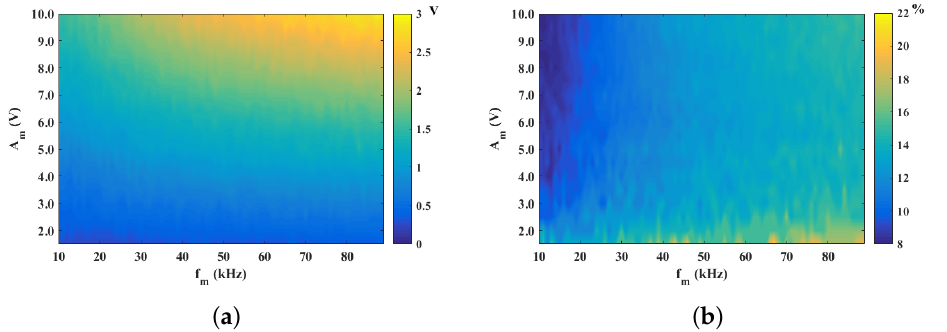
Figure 4. ( a ) voltage map of the DL emission when modulated with signal u m ( t ) = A m sin ( 2 π f m t ) . ( b ) percentage relationship of the voltage that presents the intensity of the emission of the LD with respect to the modulation amplitude A m